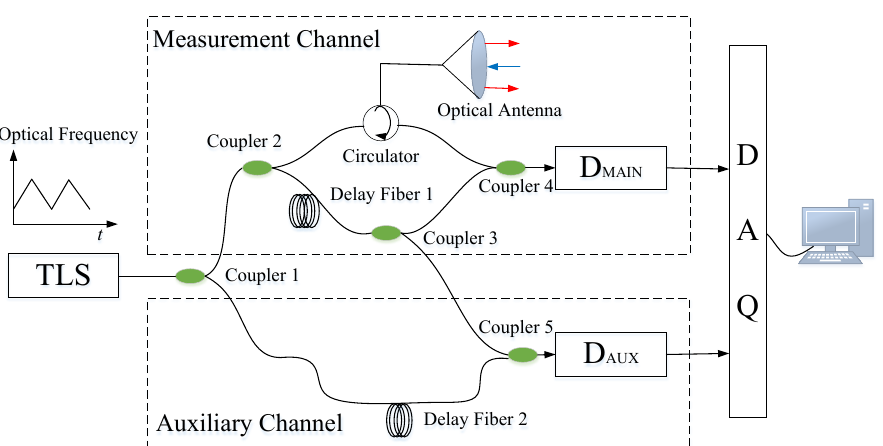
Figure 4. Schematic diagram of frequency modulation continuous wave (FMCW) coherent Lidar System. TLS: tunable laser source; D MAIN : measurement detector; D AUX : auxiliary detector; DAQ: data acquisition card.